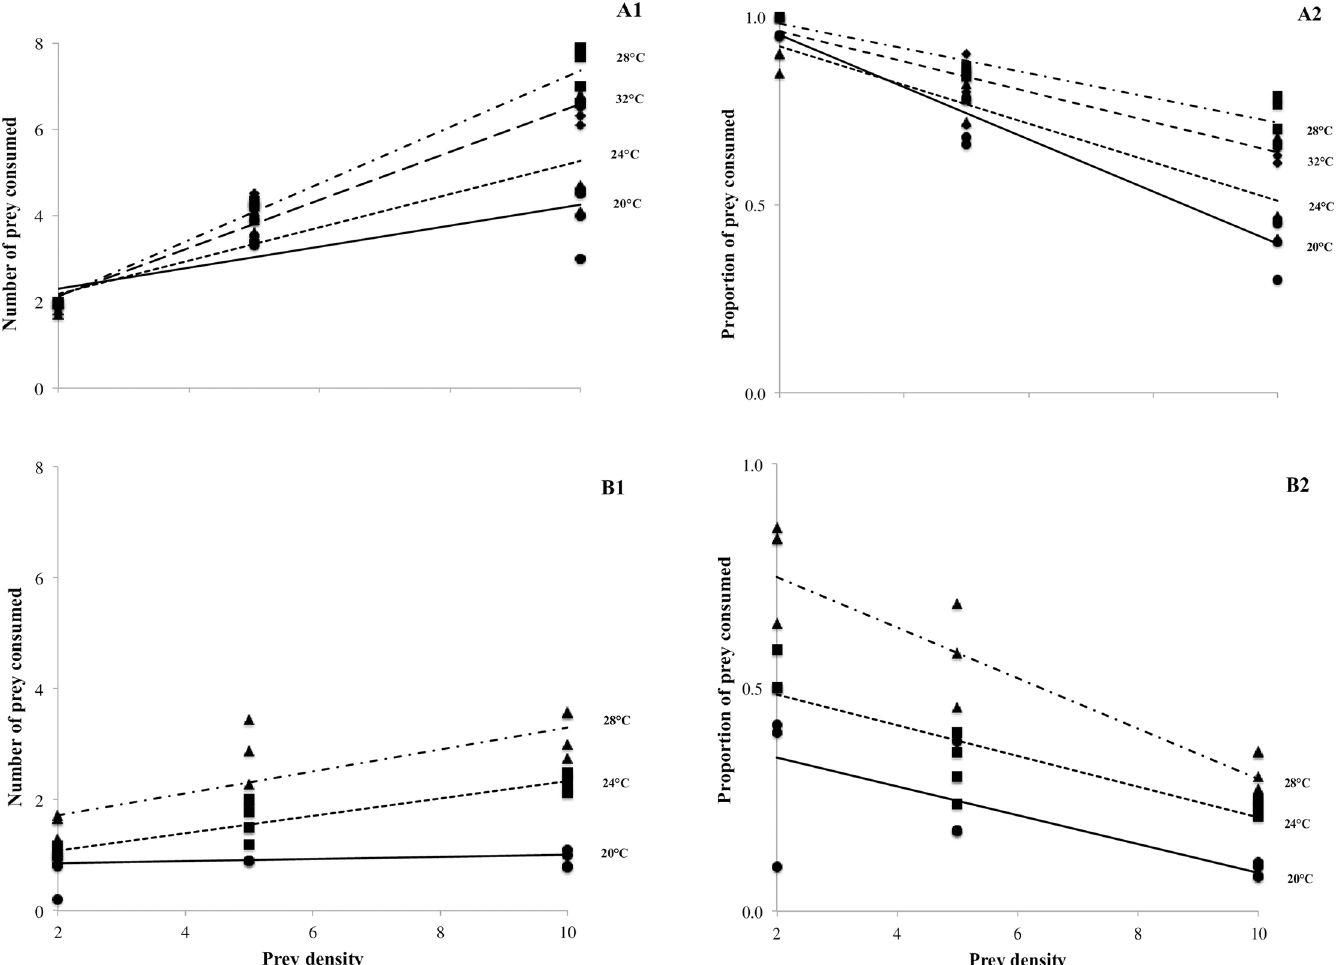
Fig 2. Prey consumed as function of prey density (A 1 and B 1 ) and prey consumed/prey offered ratio (A 2 and B 2 ) for Mesostoma ehrenbergii and Mesostoma craci , respectively. Closed circle, closed square, closed triangle and closed diamond correspond to 20, 24, 28 and 32˚C,